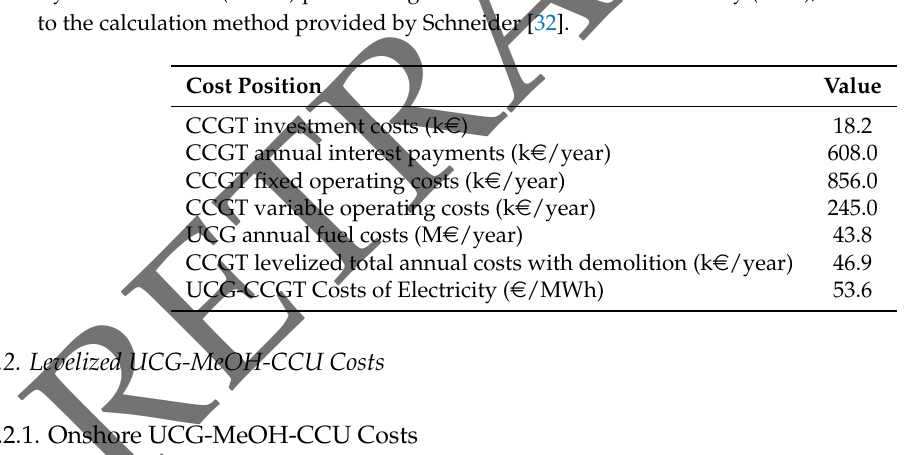
Table 10. Costs of all integrated Underground Coal Gasification (UCG) and generation in a Combined Cycle Gas Turbine (CCGT) process stages combined as Cost of Electricity (COE), determined according to the calculation method provided by Schneider